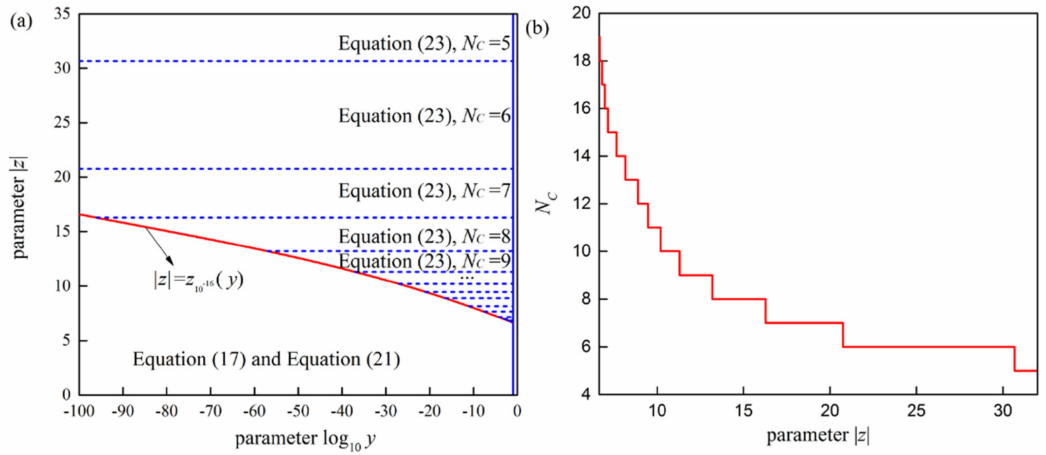
Figure 3. ( a ) The evaluation scheme for Voigt/complex error function in double-precision arith- metic and ( b ) the parameter N C for truncation of the Laplace continued fraction in the external calculation domain.